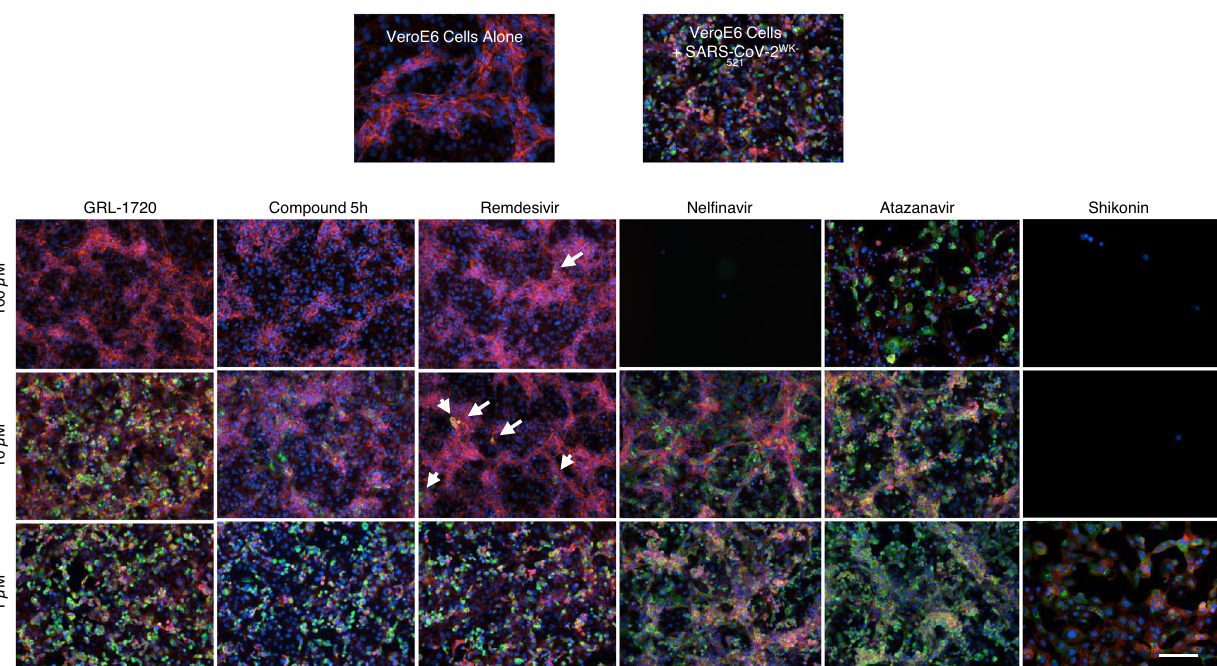
Fig. 4 GRL-1720 and 5h exert potent activity against SARS-CoV-2 WK-521 but shikonin, nel fi navir, and atazanavir, reportedly active against SARS-CoV-2, failed to block the infection by SARS-CoV-2 WK-521 . VeroE6 cells were exposed to SARS-CoV-2 WK-521 for 1 h, the viruses were washed out, and the virus- exposed cells were cultured in the presence or absence of various concentrations of each test compound for 3 days. Immunocytochemistry was then performed using an IgG fraction prepared from COVID-19-convalescent plasma as a primary antibody. Viral breakthrough was observed in the cells cultured in the presence of remdesivir at 100 µ M, while in the cells cultured with 100 µ M GRL-1720 and 5h, no such virus breakthrough was found. Arrows denote the cells infected by the virus in the presence of high concentrations of remdesivir. Such breakthrough cells (stained in green) are often seen in clusters. SARS-CoV-2 antigens, F-actin, and nuclei are stained in green, red, and blue, respectively. Representative images from three independently conducted experiments are shown. Scale bar = 100 µ